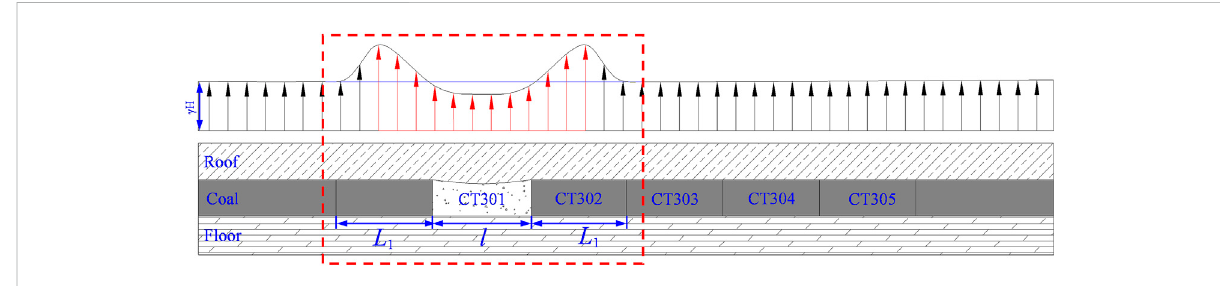
FIGURE 5 Structure 1 stress analysis diagram.